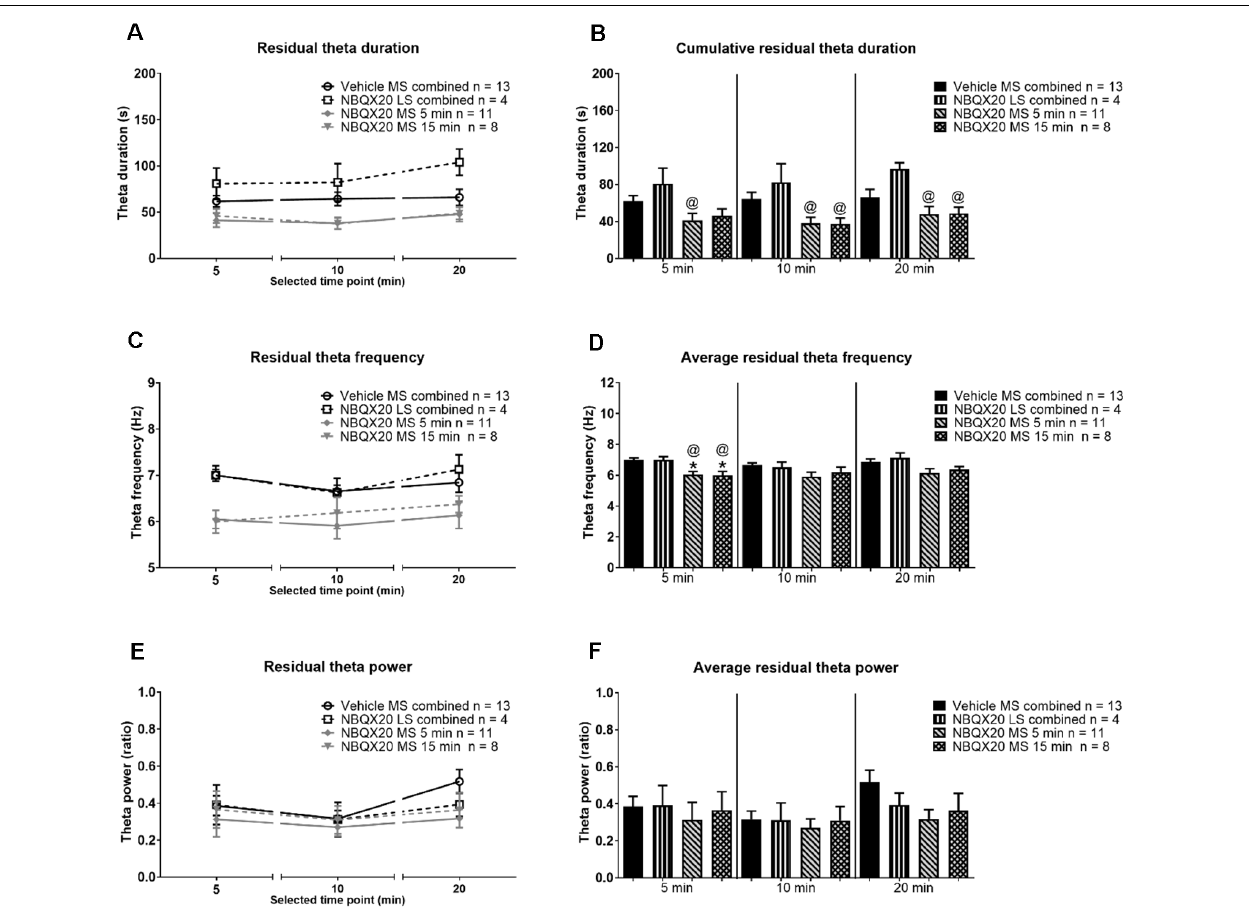
FIGURE 9 | Intraseptal microinjection of NBQX affects residual theta. The figure illustrates the effect of NBQX microinjection (20 µ g/ µ l, 0.5 µ l; NBQX20) on residual theta parameters. The figure is developed as in Figure 8 . The residual theta is theta activity observed at times other than those during formalin-induced flinching and licking. A decline in theta parameters at interphase, as compared to peaks of both Phase 1 (5 min) and Phase 2 (20 min), was not observed, indicating that residual theta is not biphasic (A,B) . Further, microinjection of NBQX into MS, but not LS attenuated the frequency of residual theta (C,D) . Microinjection of NBQX had no effect on the power of residual theta (E,F) . Data are mean ± S.E.M. Significant difference ( p < 0.05): Histograms: *vs. Vehicle and @ vs. NBQX20 LS combined, one-way ANOVA followed by Newman-Keuls post hoc